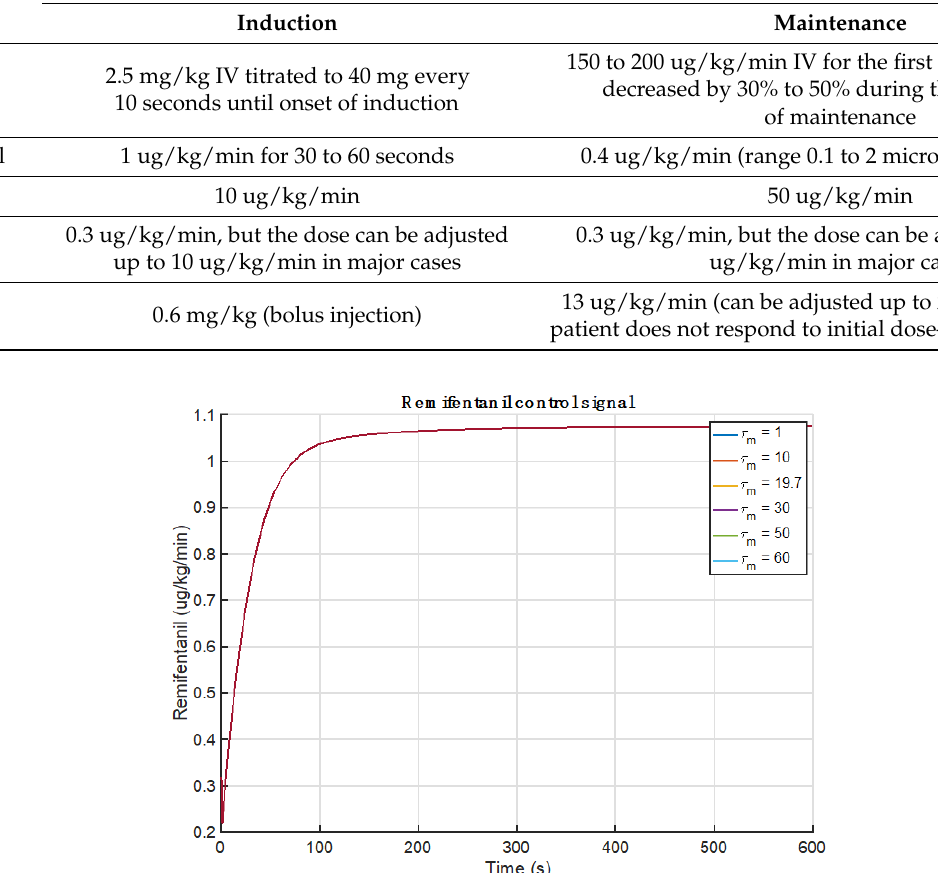
Figure 18. Computed Remifentanil values in the case of dead-time variations in BIS measurement.